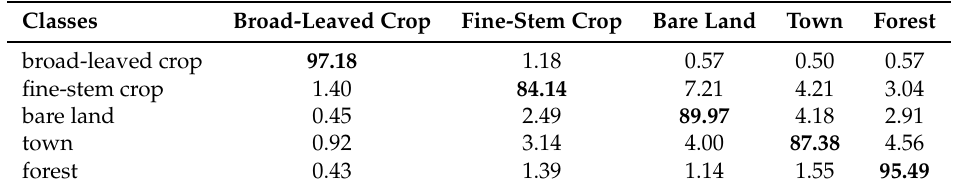
Table 6. Confusion matrix (%, category accuracy is shown in bold) of TSNE-FCN+SVM algorithm on Foulum dataset.